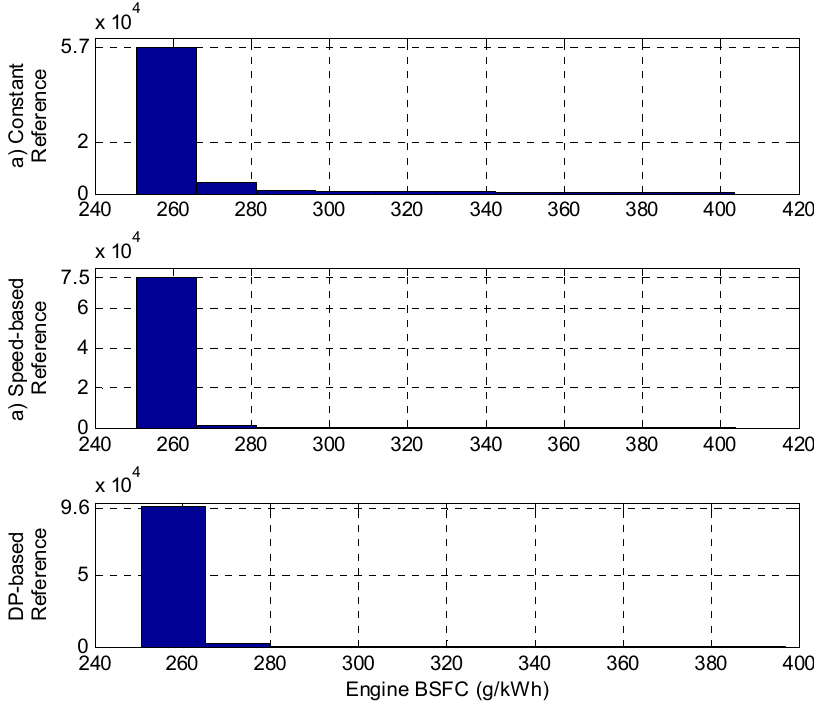
Figure 18. Number of Occurrence of Engine Operating Points on BSFC map.